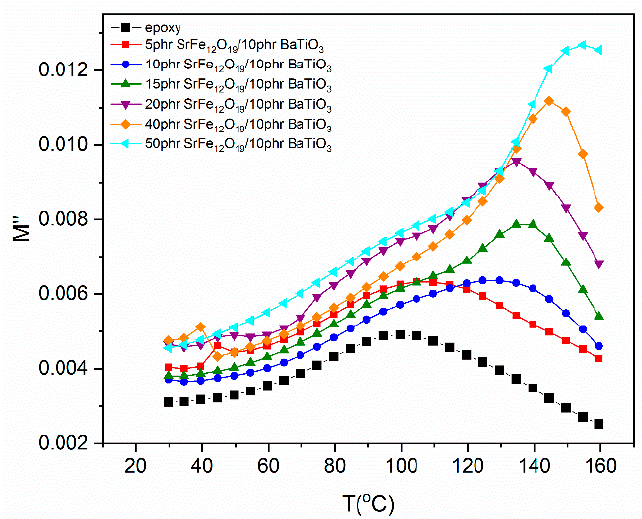
Figure 7. Imaginary part of electric modulus versus temperature for all systems at 1 MHz. Cole–Cole plots for the 10 phr SrFe 12 O 19 /10 phr BaTiO 3 /epoxy nanocomposite at var-